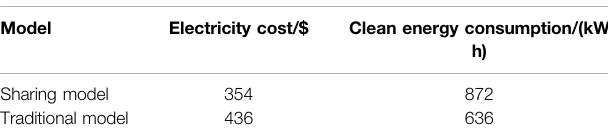
TABLE 3 | Data of the compromise